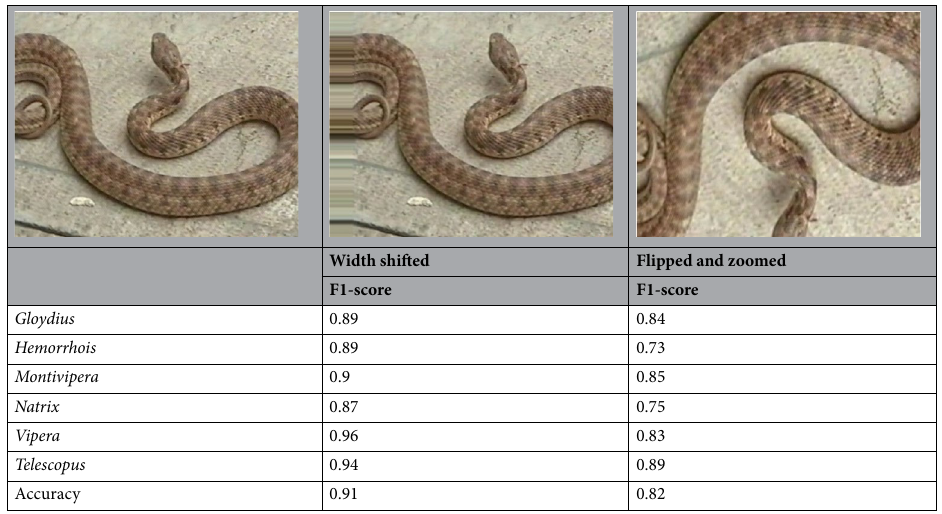
Table 4. The F1-score and overall accuracy of MobileNetV2 model for modified test images datasets (augmented via width shift as well as vertical flip and zooming) showing the robustness of the model.